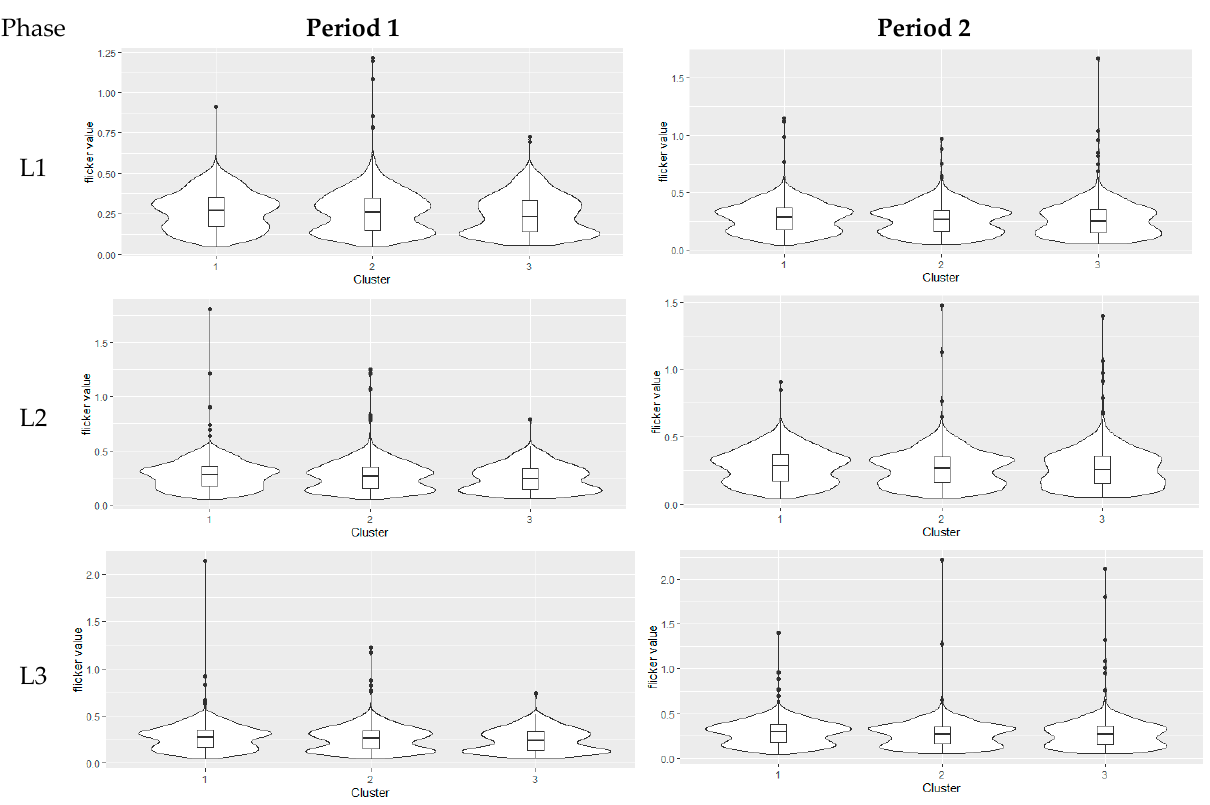
Figure 10. Violin plots of power-line flicker comparing clusters for Period 1 and Period 2 in each phase. Table 13. Wilcoxon rank-sum test of the power-line flicker ( α = 0.05) in each phase.